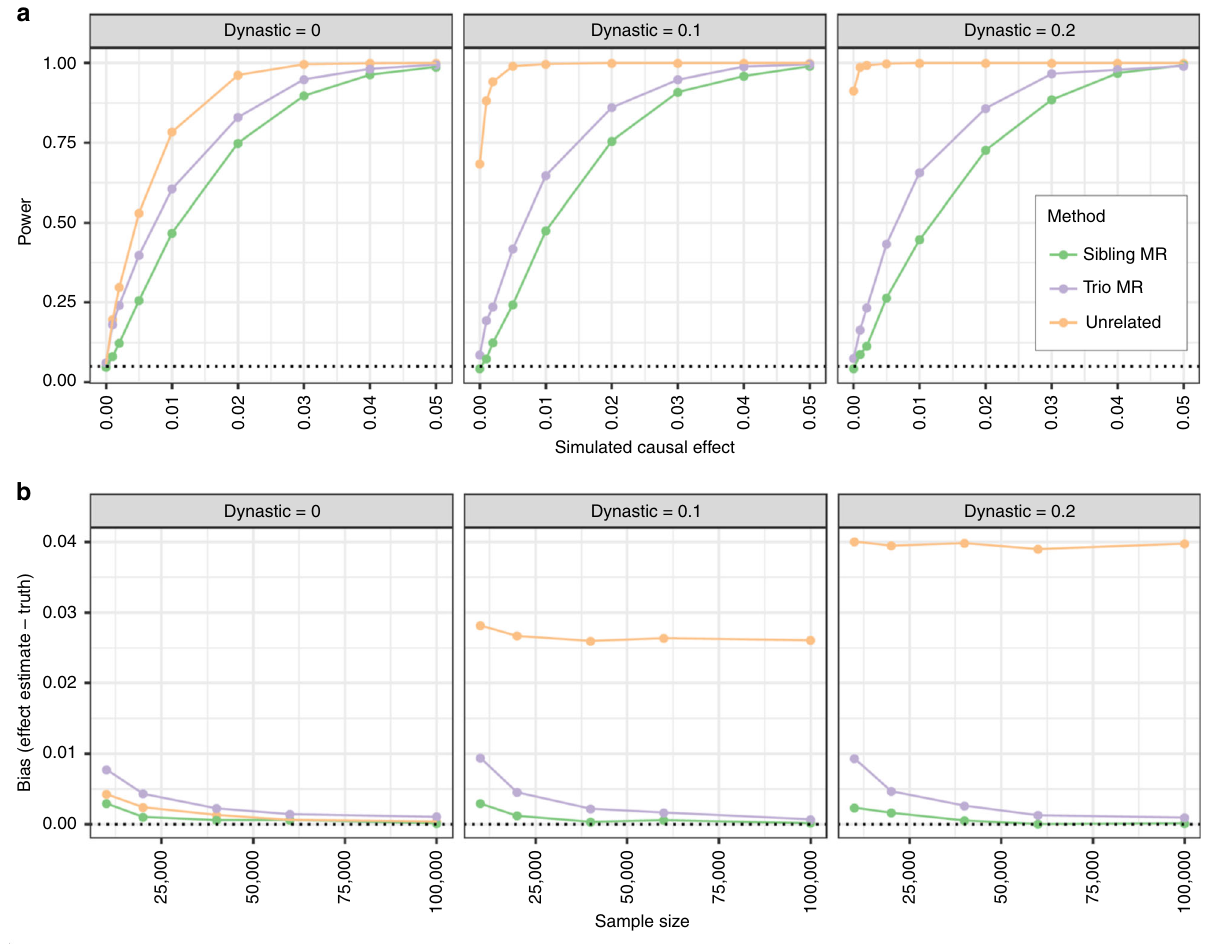
Fig. 2 Results of simulations comparing different Mendelian randomization study designs for power and bias. a SNP-exposure r 2 = 0.05; sample size = 10000 singletons, sibs, or trios; simulation involves an in fl uence of parental exposure in fl uencing child ’ s confounder, which explains 10% of variance in child exposures and outcomes. For a simulated causal effect = 0, we expect the false discovery rate to be 0.05. b Estimated bias by sample size using different Mendelian randomization designs. The simulations are similar to a but allow sample size to vary and fi xing the causal effect of an exposure x on an outcome y to 1% of variance explained. The bias in within-family Mendelian randomization estimates is slightly elevated when sample sizes are small due to weak instrument bias, but are otherwise are protected from the large bias seen when using unrelated